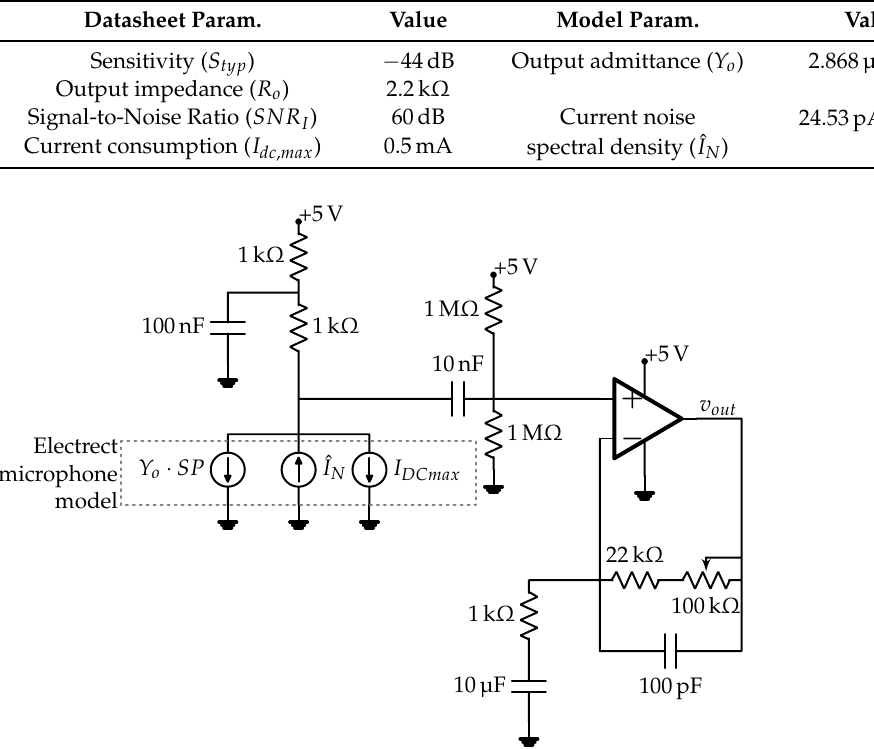
Figure 7. Circuit model of CMA-4544PF-W electret condenser microphone with pre-amplifying stage built in around the low-noise OA